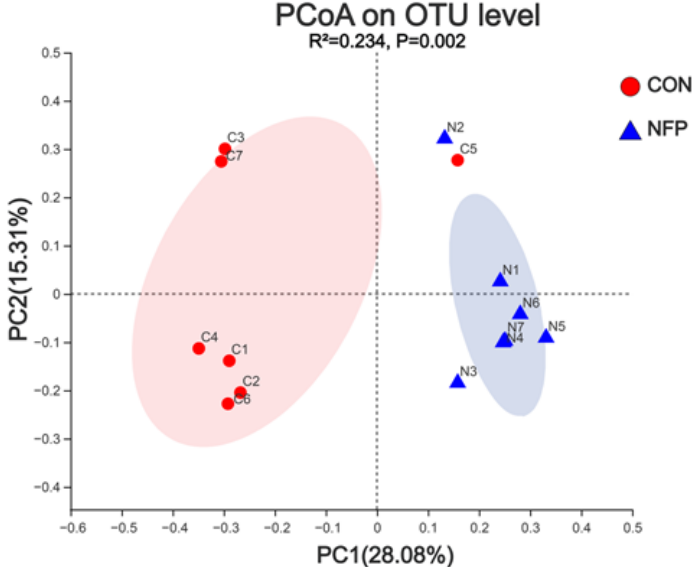
Figure 3. Principal coordinate analysis (PCoA) of ruminal microbiome in goats between CON and NFP group in Exp. 2 ( n = 7). The pink part was the confidence interval of control (CON). The purple parts was the confidence interval of polysaccharide-rich extract of noni fruit (NFP).